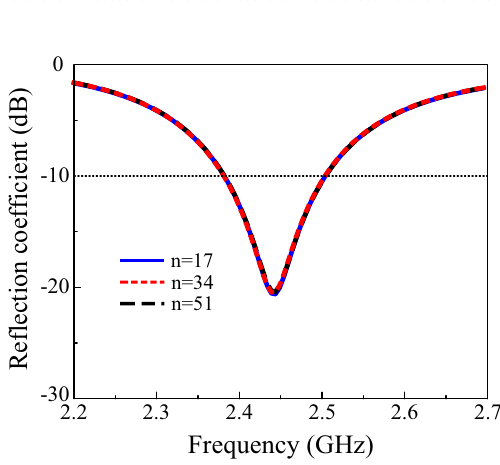
Figure 4. Reflection coefficients with varying slot lengths.